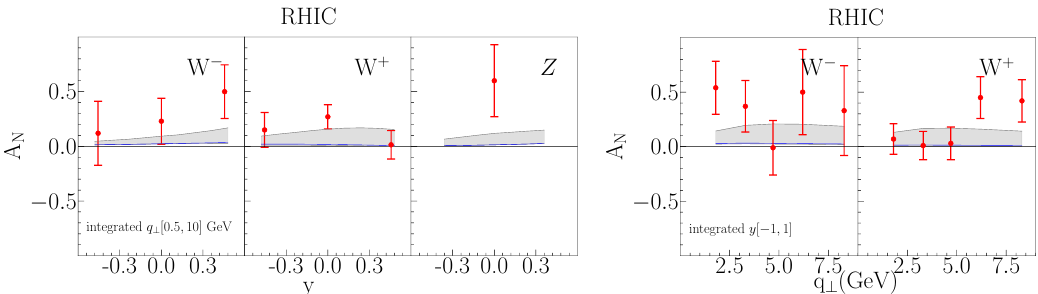
√ S = 500 GeV [47]. The central curve and